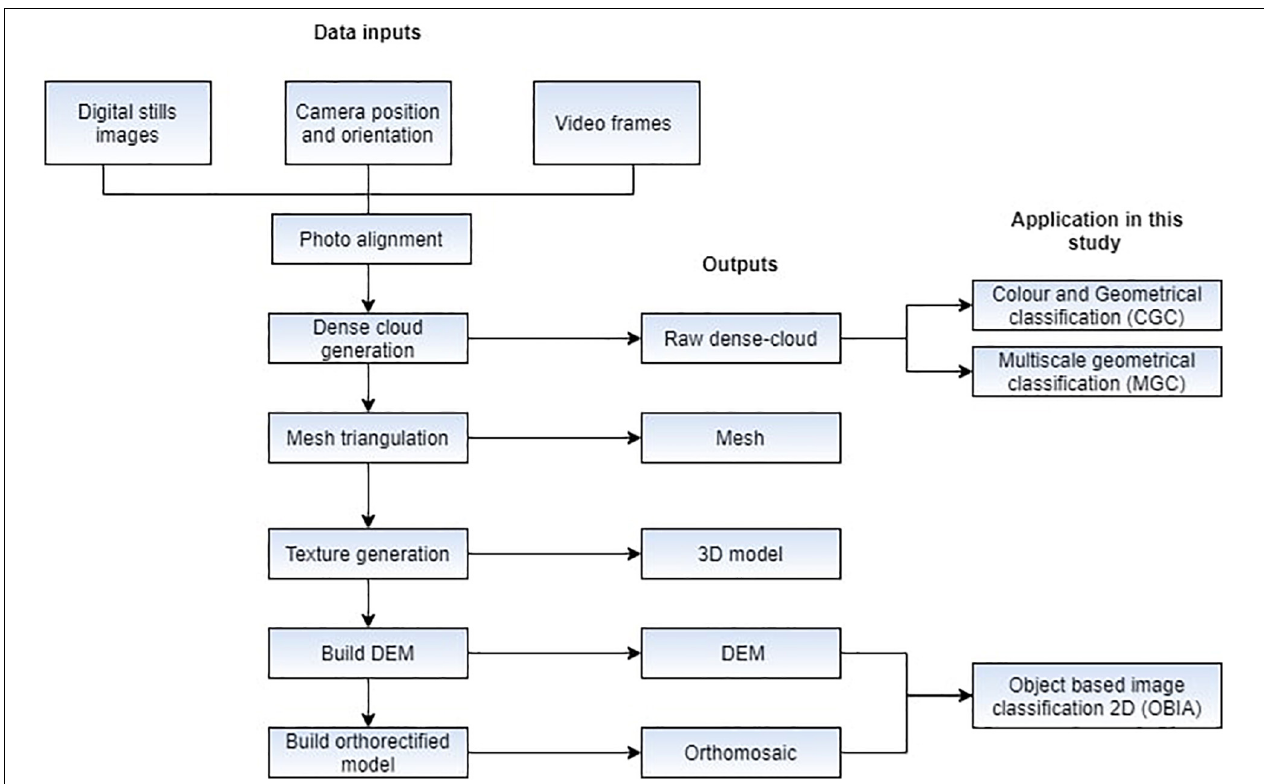
FIGURE 2 | Workflow for 3D model reconstruction and applications of each output data within this